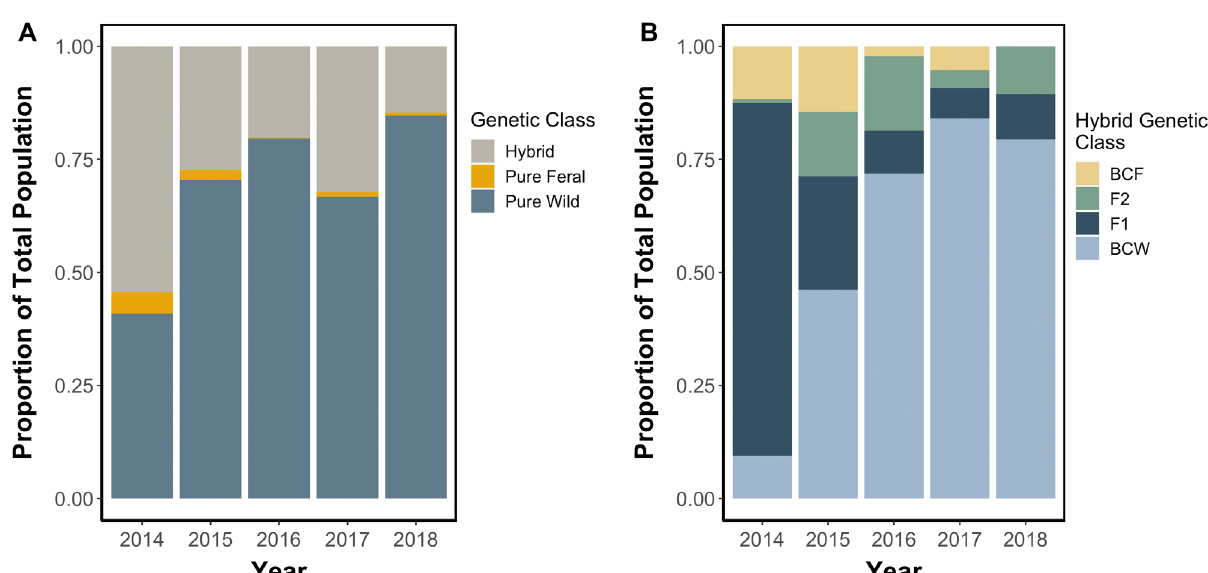
Fig. 4. Proportions of genetic classes for the total southern Newfoundland population of Atlantic salmon scaled by river axial length as a proxy for population size, for each year sampled. (A) total proportions for pure wild, pure feral, and hybrid genetic classes, where hybrid cumulatively represents all 4 hybrid categories. (B) Total proportions for the hybrid genetic classes, backcross farmed/feral (BCF), F2, F1, and backcross wild (BCW), for the hybrid proportion indicated in